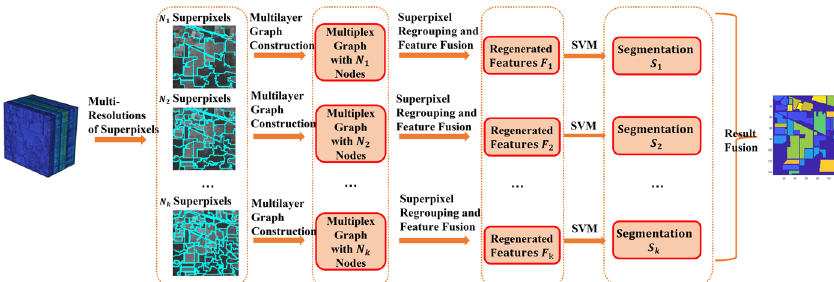
Fig. 5 Scheme of MLG-based supervised HSI classification